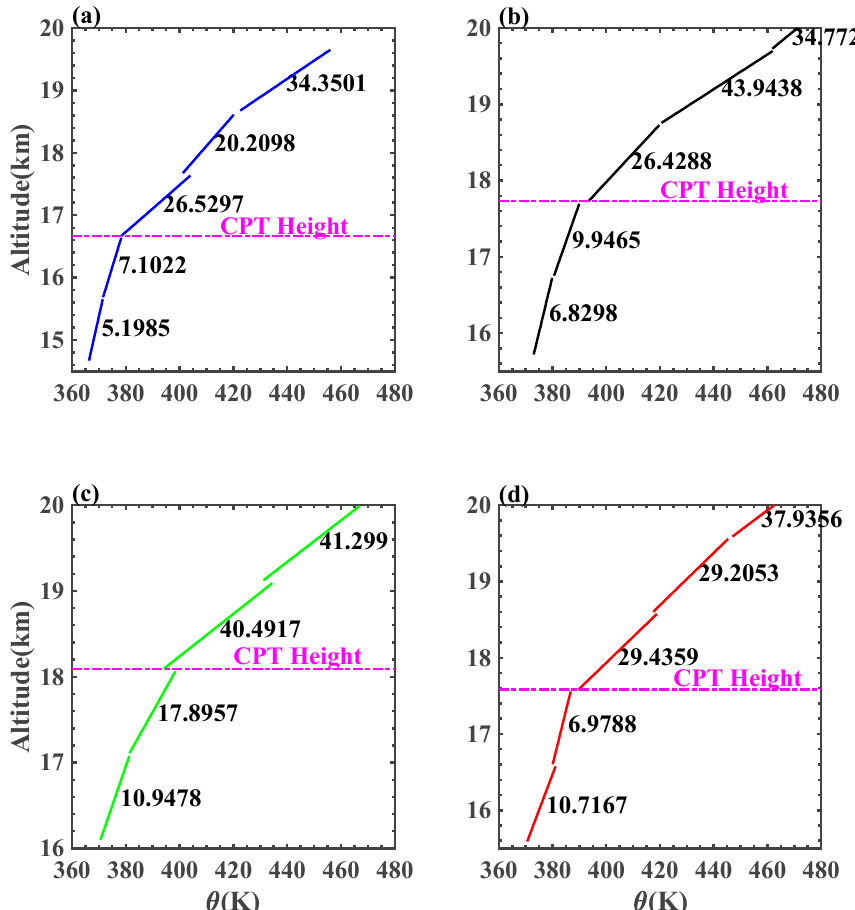
Figure 7. The piecewise fitting lines of potential temperature in tropopause and lower stratosphere. The potential temperature profiles are linearly fitted with the least-square method at intervals of 1000 m. The numbers indicate the coefficients (unit: K/km) of the piecewise fitting, indicating the potential temperature lapse rates. The pink dotted lines represent the corresponding CPT heights. ( a ) 12 August 2018, ( b ) 13 August 2018, ( c ) 14 August 2018, and ( d ) 16 August 2018.